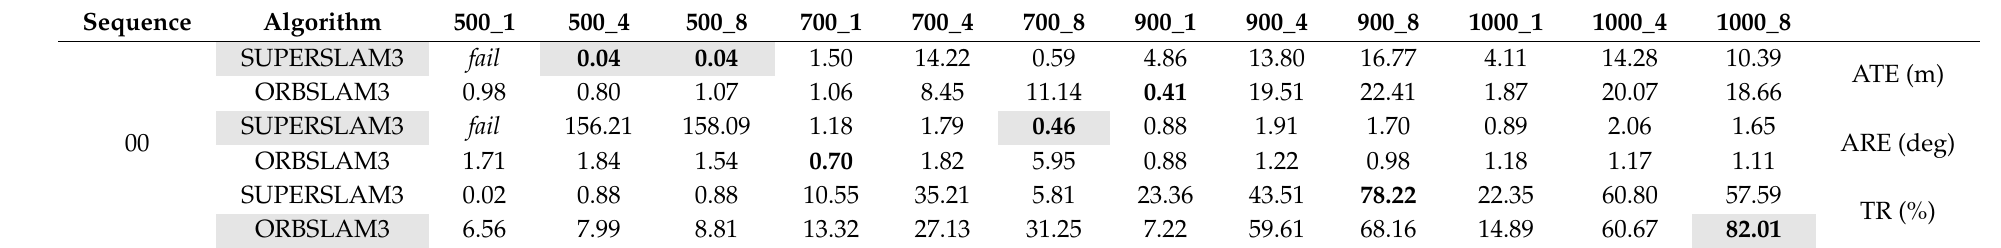
Table 2. Quantitative results on KITTI. For each sequence and for each performance metric, we highlight in bold the parameter configuration that attained the best result (for both ORBSLAM3 and SUPERSLAM3) individually for each analyzed metric (as described in the table’s right header). To indicate the one with the highest performance between the two, we color the corresponding cell and highlight the algorithm name in gray. In the table’s top header the parameters set are represented in the form ‘ nFeatures_nLevels